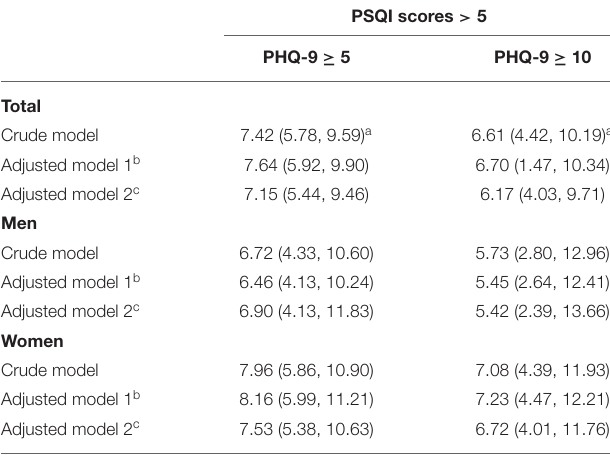
TABLE 3 | Associations between PSQI scores and depressive symptoms *